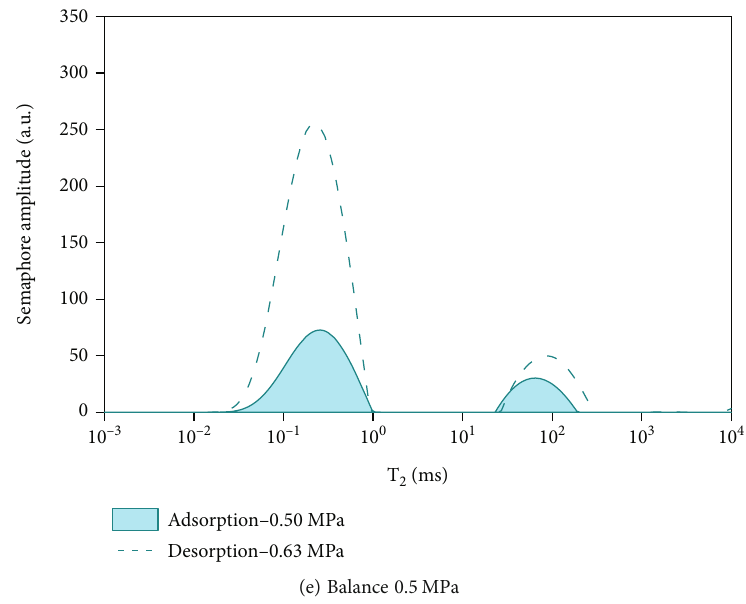
Figure 10: Comparison of T 2 spectrum distribution diagram of adsorption and desorption under equilibrium pressure. Table 4: Adsorption and desorption amount under di ff erent pressures.